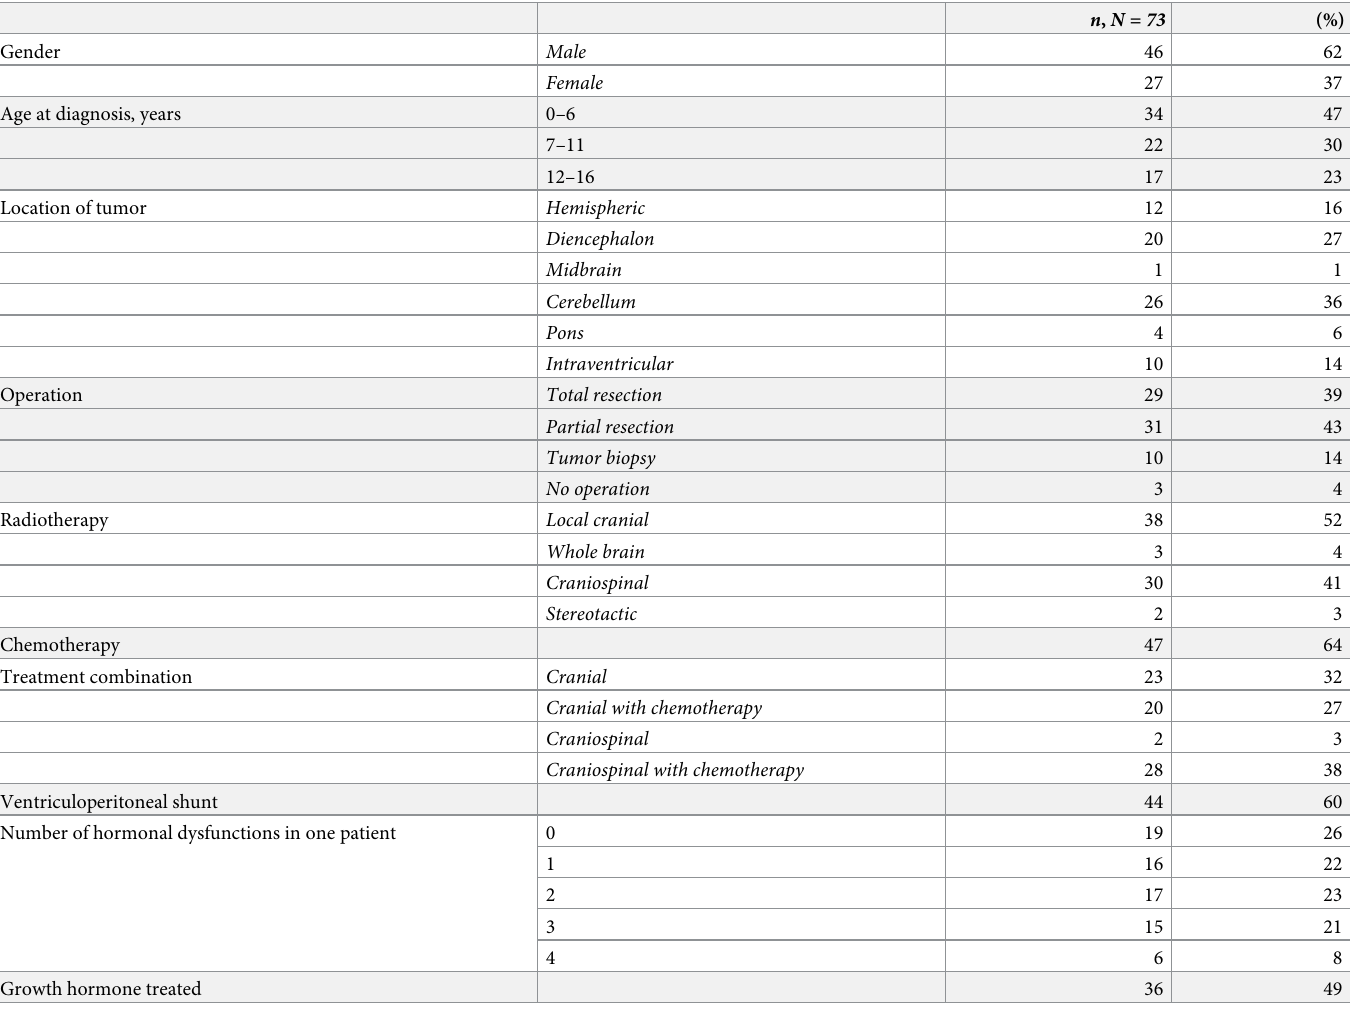
Clinical and demographic data of the entire study population are shown in Table 1. Almost half of the subjects (46%, n = 34) were diagnosed with brain tumor before the age of 7 years. In 52% (n = 38) of the subjects, the tumor was infratentorial. Tumors located in the diencephalon, potentially affecting the function of the hypothalamus pituitary function, were diagnosed in 27% (n = 20) of the subjects. Of the subjects, 59% (n = 43) had received cranial radiotherapy (CRT) and 41% (n = 30) had received craniospinal therapy (CSRT). Other brain tumor treat- ments included surgery and/or chemotherapy (Table 1). The majority of the subjects had undergone surgical operation, and over half had received chemotherapy. Of all the ventriculo- peritoneal shunts (VPS), 45% (n = 20) and 11% (n = 5) were found in subjects with cerebellar tumors and tumors located in the fourth ventricle, respectively. Table 1. Clinical and demographic data on the 73 childhood brain tumor survivors. n , N = 73 (%)